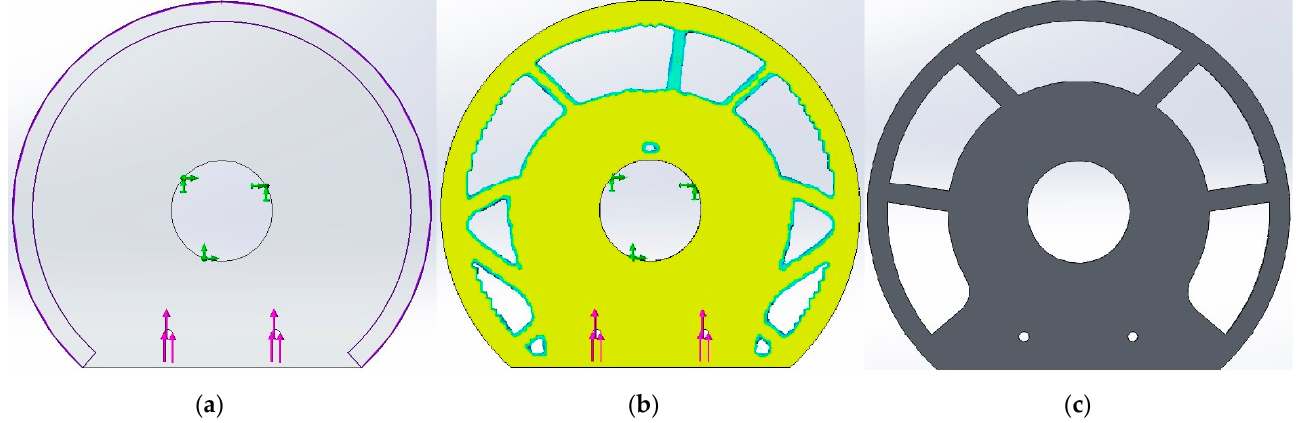
Figure 14. ( a ) Original part with applied manufacturing constraints, ( b ) Mass reduction plot from topology optimization study, ( c ) Optimized shape used in final model.